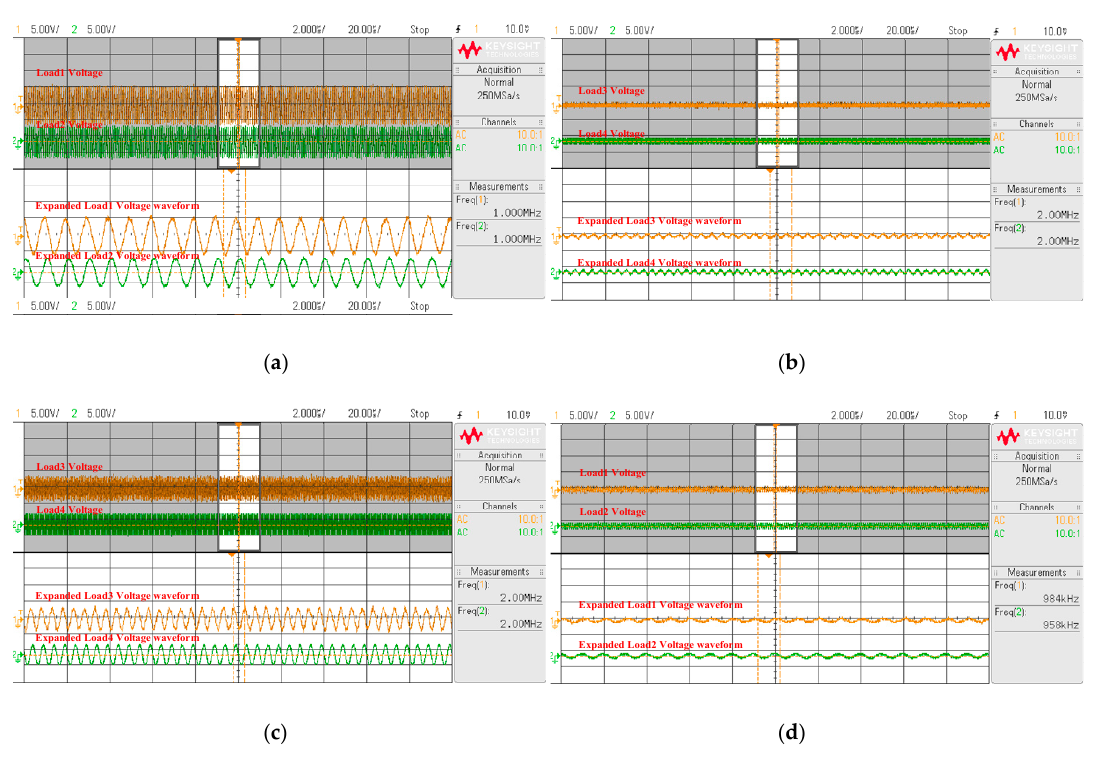
Figure 17. Measured load voltage of selective wireless power transfer (WPT) with two identical Rx resonant frequency ( a ) V L 1 , V L 2 at f r 1 = f r 2 = 1 MHz ( b ) V L 3 , V L 4 at f r 1 = f r 2 = 1 MHz ( c ) V L 3 , V L 4 at f r 3 = f r 4 = 2 MHz ( d ) V L1 , V L2 at f r 3 = f r 4 = 2